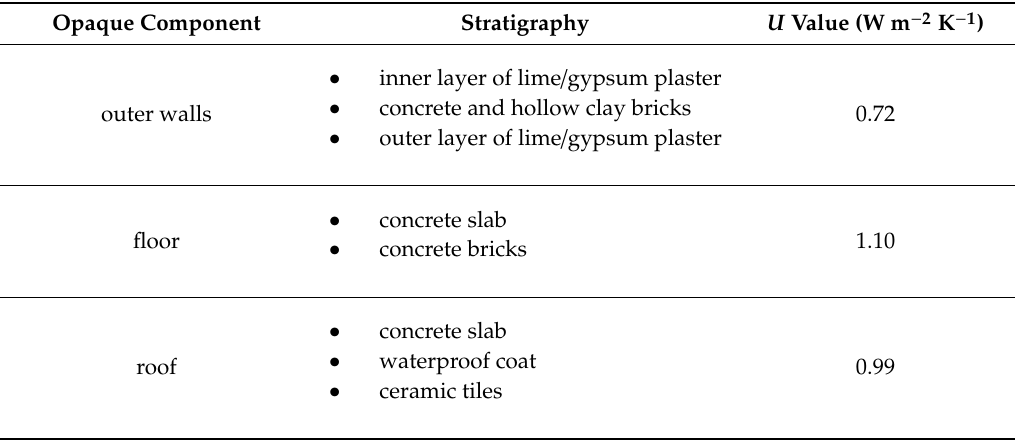
Figure 2. Test-classroom scheme: dimensions in brackets are representative of the height. Table 1. Stratigraphy and thermophysical parameters of the building envelope opaque components.